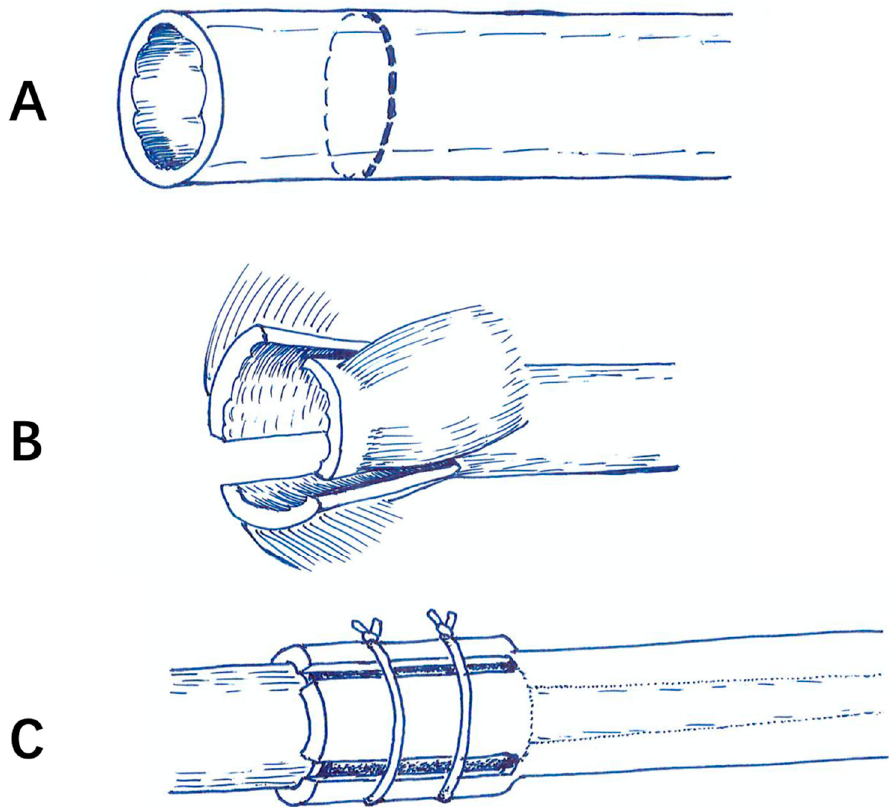
Figure 1. ( A ) After the cement was removed, the cortical pedicle was marked 4–5 cm away from the bone end. ( B ) The cortical pedicle was divided into three equal parts with a pendulum jigsaw. The procedure was carefully performed to keep the muscle attachments and periosteum. ( C ) The cortical pedicle autograft was affixed to this porous coating section with one or two wires to make a bone-bridging.